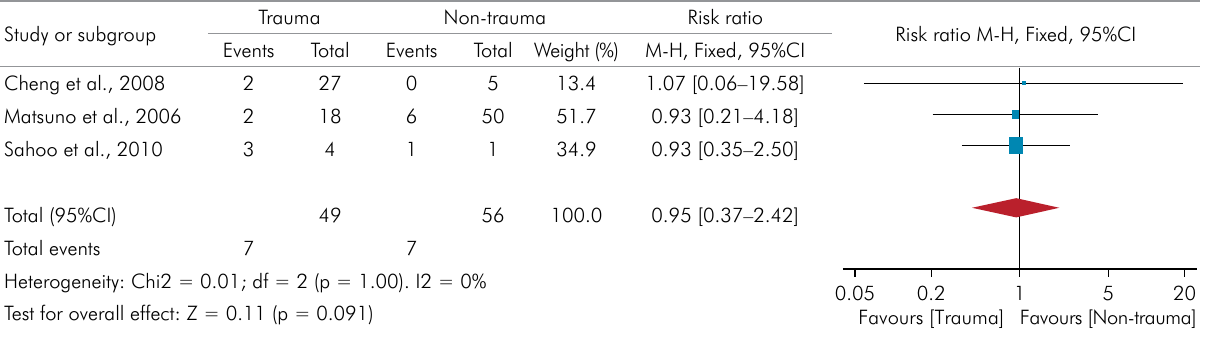
Figure 4. Forest plot: comparison of indication (trauma/non-trauma) and occurrence of complications when PMMA was used as the material of